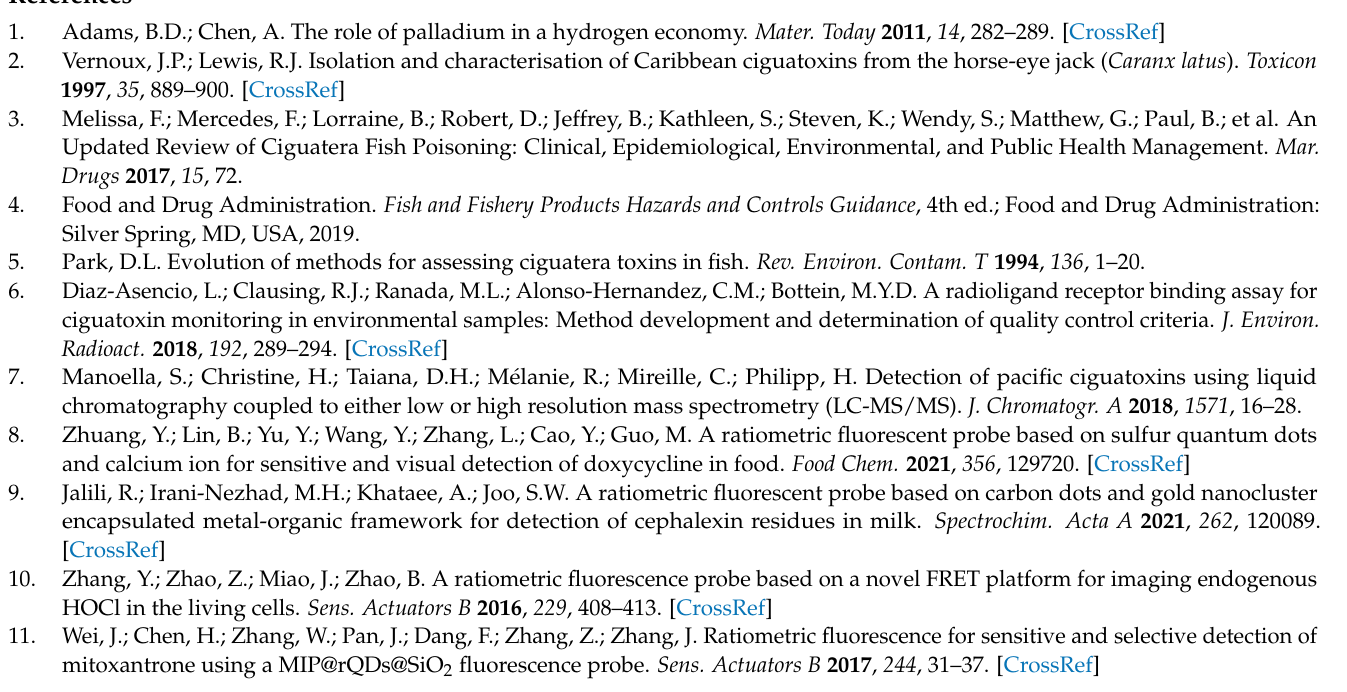
Figure S4: Fluorescence spectra of RCDs and BCDs (a), linear curve comparison of BCDs and quinine sulfate (b), quantum yield of RCDs (c); Figure S5: Molecular formulas of P-CTX-3C (a), monensin (b), nigericin (c), rotenone (d), ionomycin A (e), and lysozyme (f); Figure S6. Four rounds of absorption and desorption of